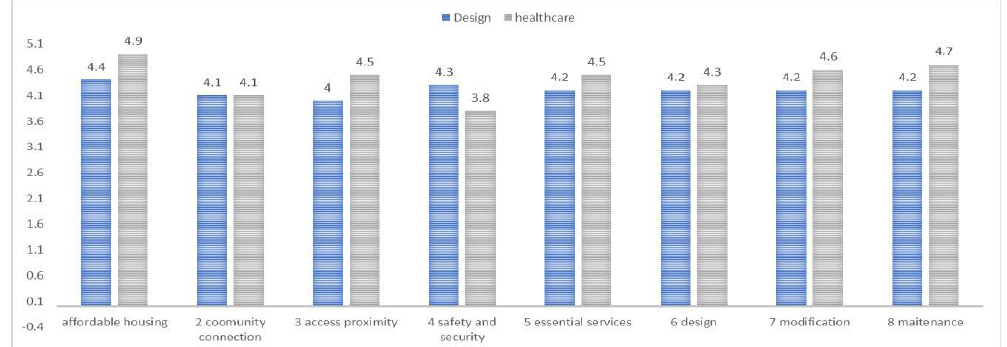
Figure 5. Comparative assessment result from health and design domain experts.